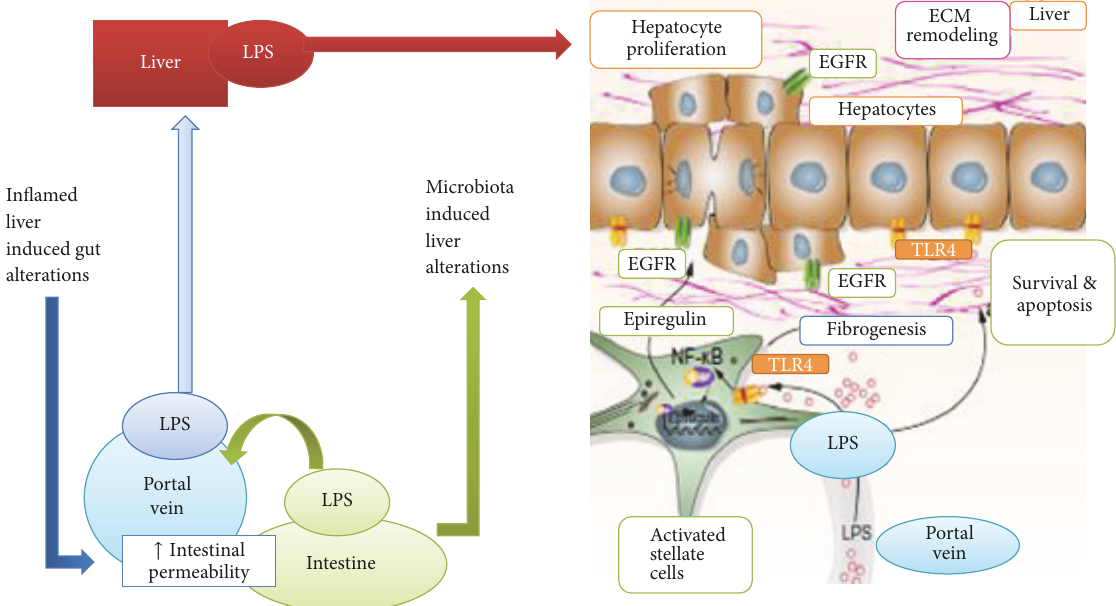
Figure 3: Schematic diagram showing progression of HCC by TLR4 pathway. Gut permeability alterations and LPS translocation to liver cause liver damage and activation of TLR4 signaling in HSC and hepatocytes result in ECM makeover, fibrogenesis, and exudation of EGF leading to HCC.